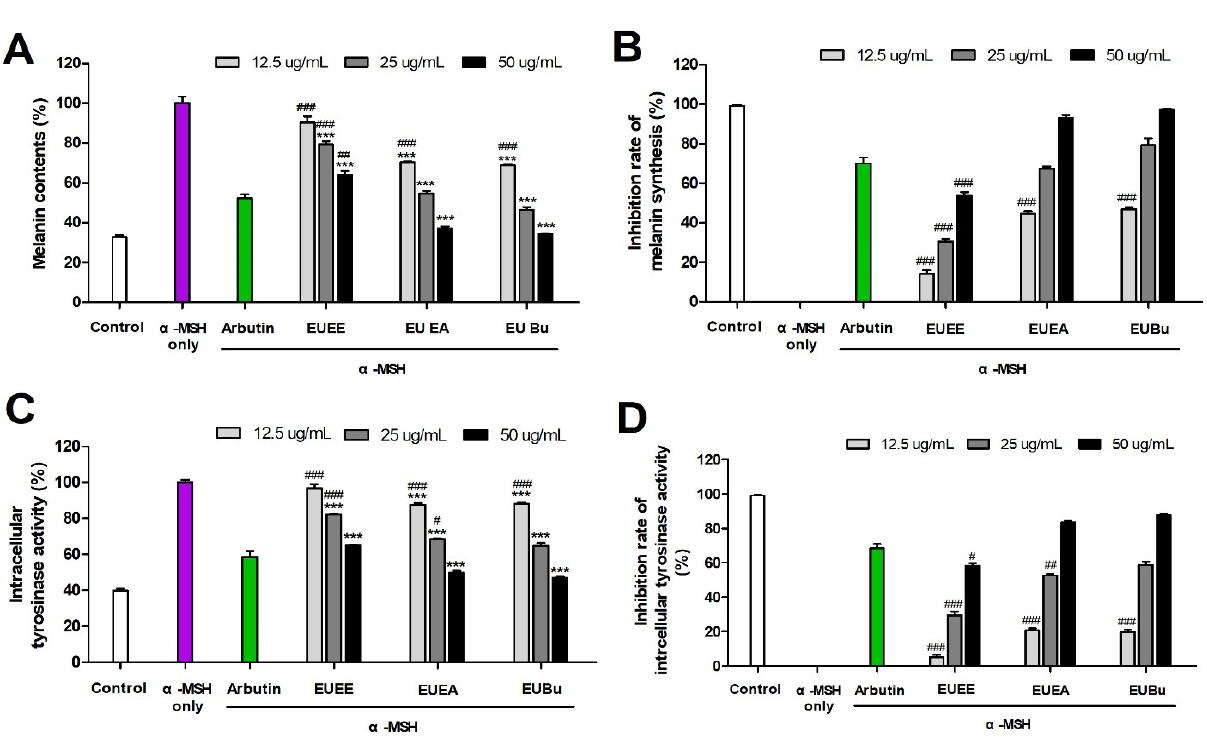
Figure 4. Melanin synthesis and cellular tyrosinase activities of EU. Melanin contents of EU extract and fractions in B16-F10 melanoma cells ( A ). Inhibition rate of melanin synthesis of EU extract and fractions in B16-F10 melanoma cells ( B ). Intracellular tyrosinase activity of EU extract and fractions in B16-F10 melanoma cells ( C ). Inhibition rate of intracellular tyrosinase activity of EU extract and fractions in B16-F10 melanoma cells ( D ). Results ( A , C ) are presented as percentages based on the α -MSH group. Results ( B , D ) are presented as percentages based on the control group. Data are expressed as the means ± S.E.M. (n = 3). Statistical significance was set at *** p < 0.001 when compared with the α -MSH-stimulated B16-F10 cells, and # p < 0.05, ## p < 0.01, and ### p < 0.001 compared with the arbutin group.